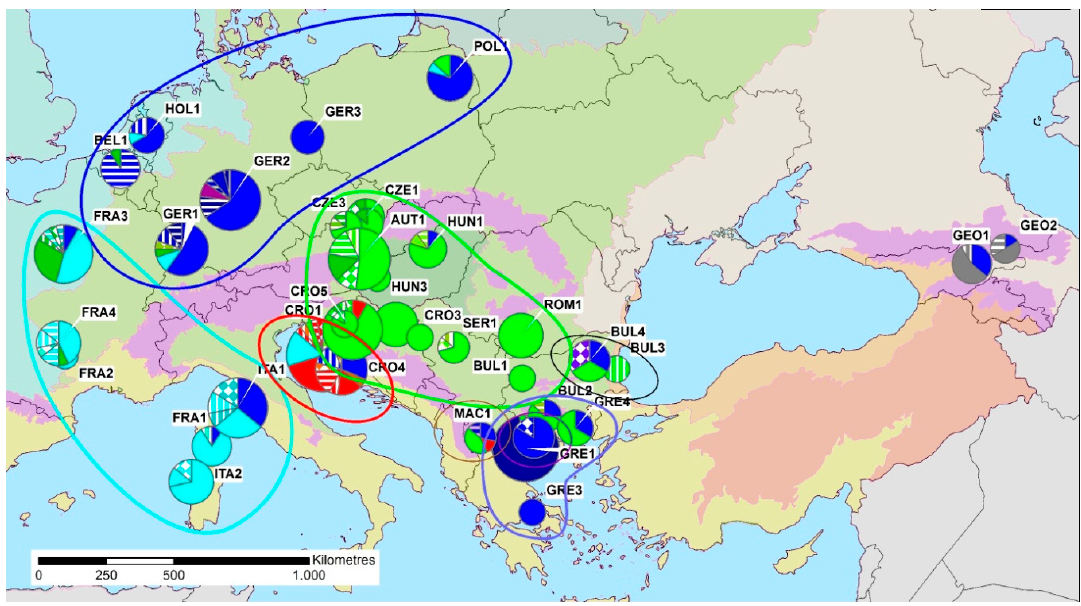
Figure 2. Haplotype distribution of Lymantria dispar in Europe. Colored circles represent the clades according to parsimony network (Figure 1), acronyms indicate localities (Table 1) and dimension of pies are proportional to sample size and haplotype abundance. Underlaying map represents biogeographic regions of Europe [33]. The figure was constructed using ArcMap 10.1 (ESRI, Redlands, CA, USA).